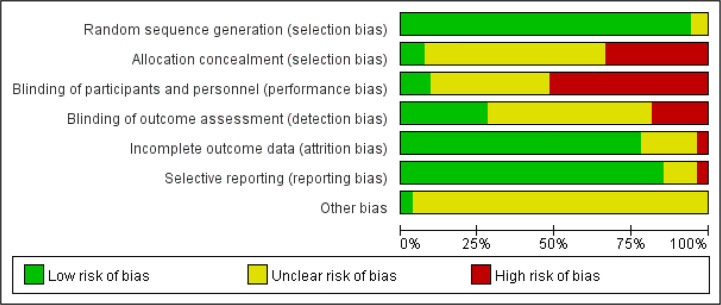
Risk of bias graph.